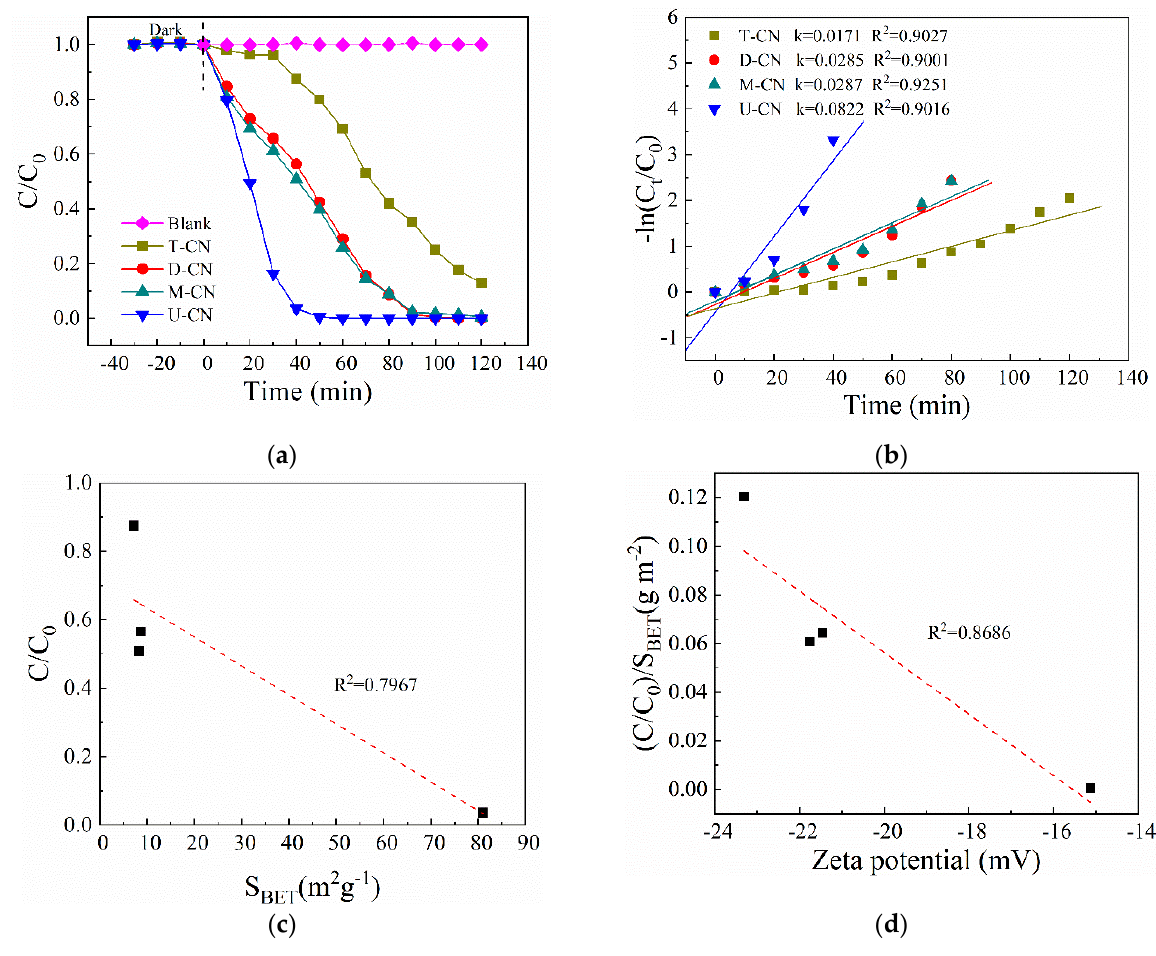
Figure 5. ( a ) Effect of materials on the photocatalytic activity of g-C 3 N 4 , ( b ) Photodegradation kinetic constants of g-C 3 N 4 prepared from different materials, ( c ) Correlation of C/C 0 and specific surface area (S BET ), ( d ) Correlation of N content and normalized C/C 0 (k/S BET ). (Experimental conditions: initial Cr(VI) concentration = 50 mg L − 1 ; catalyst amount = 50 mg; reaction volume = 150 mL; citric acid = 0.9 Mm; pH = 3; white light